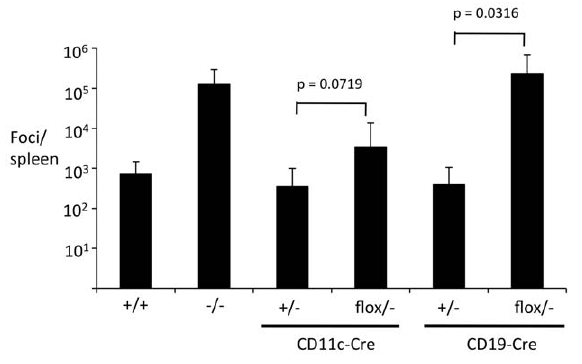
Figure 1. B cell-intrinsic TLR signaling is required for control of FV. Mice that were heterozygous ( + / 2 ) or knockout ( 2 / 2 ) for Myd88, and mice with Myd88 deleted in DCs (CD11c-Cre/ Myd88 flox/ 2 ) or B cells (CD19-Cre/ Myd88 flox/ 2 ) were infected with FV, and viral infectious centers were determined at 14dpi by measuring focus-forming units per spleen. Each bar represents an average of 6–10 mice.